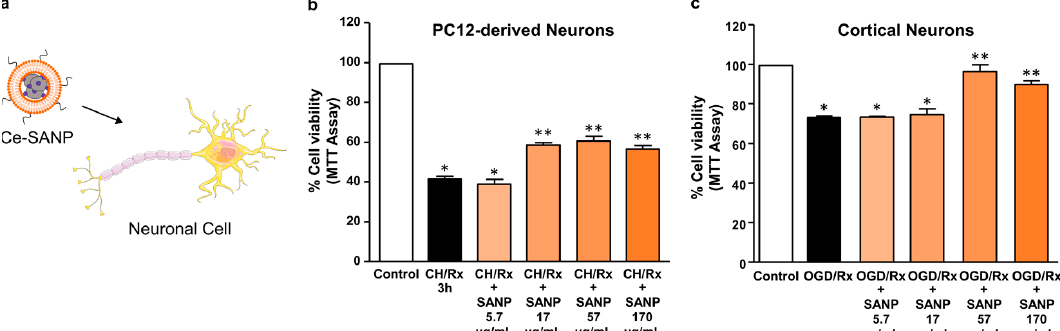
Figure 7. Effects of Ce-SANP on mitochondrial activity in primary cortical neurons exposed to OGD followed by reoxygenation and differentiated PC12 cells exposed to chemical hypoxia. Ce-SANPs were added to neuronal cells under oxidative stress conditions ( a ) at various concentrations (the schematic was partly generated using Servier Medical Art, provided by Servier, licensed under a Creative Commons Attribution 3.0 unported license). Dose-dependent effects of Ce-SANP on cell viability, measured as mitochondrial activity, in ( b ) PC12 cells differentiated with NGF and exposed to chemical hypoxia followed by reoxygenation (CH/Rx) and ( c ) primary cortical neurons exposed to OGD followed by reoxygenation (OGD/Rx). In both cases, Ce-SANPs were added only during the reoxygenation phase. The white bars represent cells treated with vehicle while the black bars represent the cells under oxidative stress conditions without the addition of Ce-SANP. * p < 0.05 vs.